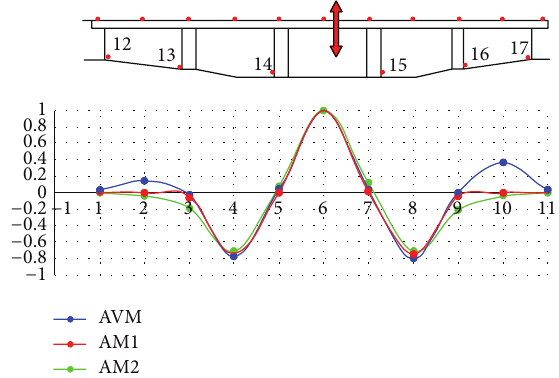
Figure 14: Experimentally and mathematically identified first verti- cal mode